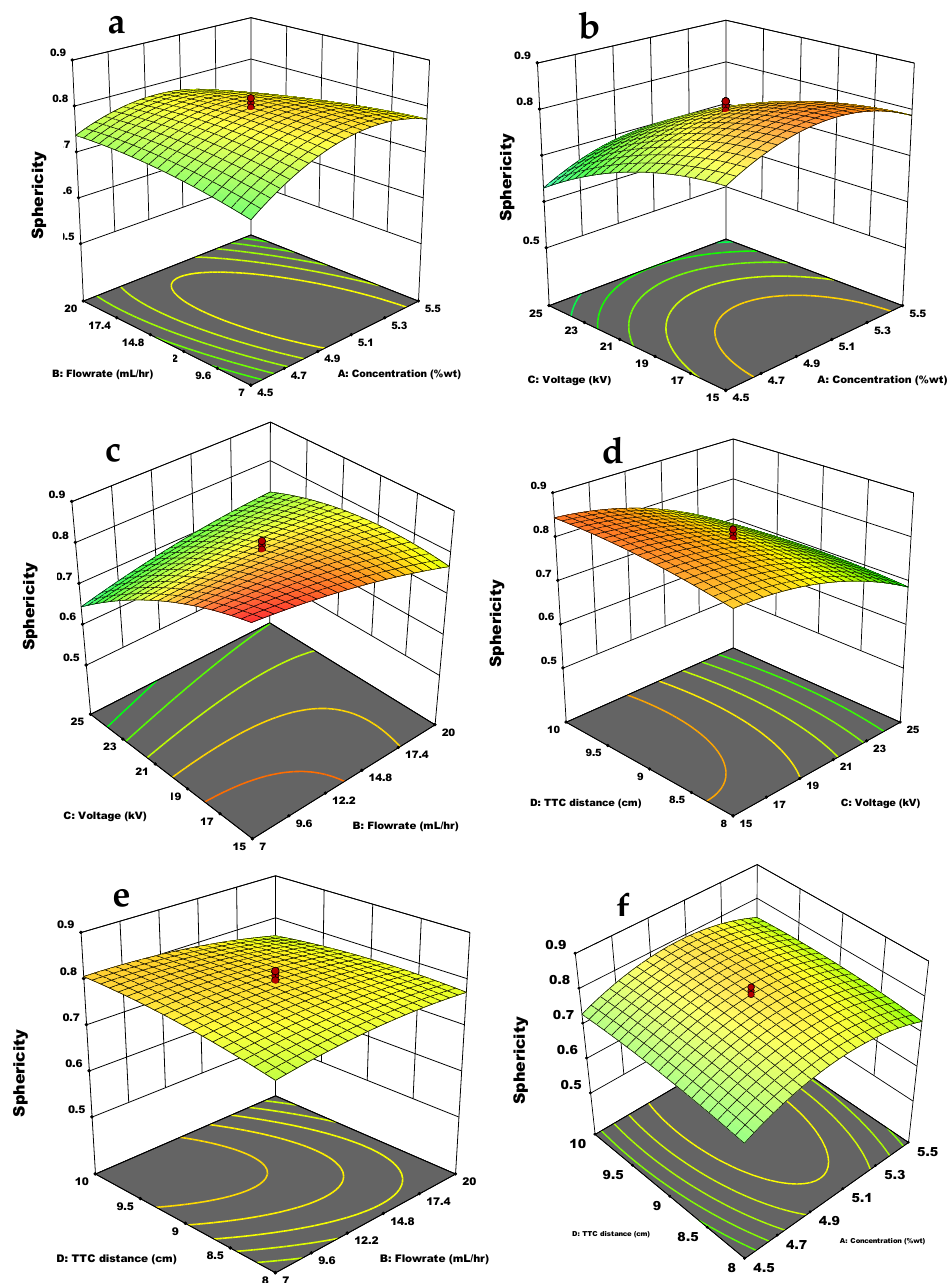
Figure 3. Response surface plot of the interaction effect of independent variables on sphericity: ( a ) Flow rate and concentration; ( b ) Voltage and concentration, ( c ) Voltage and flow rate; ( d ) TTC distance and voltage ( e ) TTC distance and flow rate; ( f ) TTC distance and concentration.